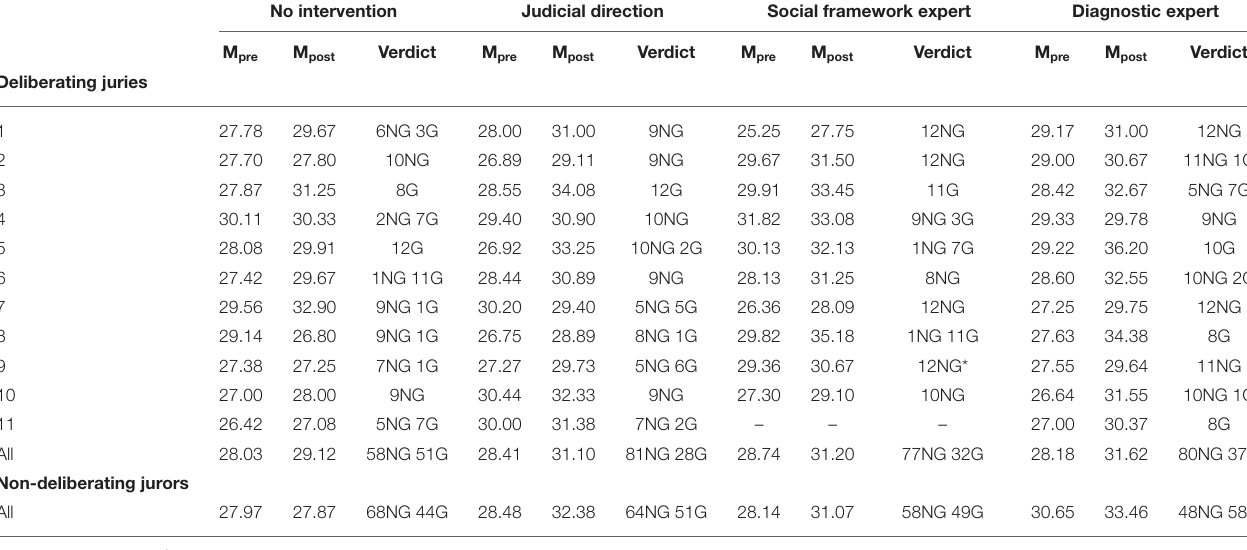
TABLE 3 | Mean pre- and post-trial CSA knowledge and verdict for each deliberating jury and non-deliberating jurors, by experimental condition. No intervention Judicial direction Social framework expert